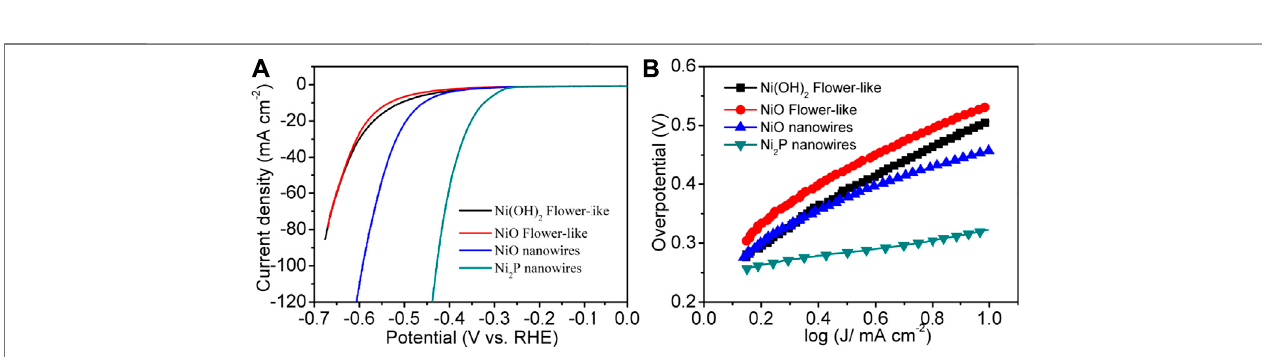
FIGURE 5 | (A) LSV curves of Ni 2 P nanowires, NiO nanowires, Ni(OH) 2 fl ower-like at 5 mV s − 1 in 1 M KOH from − 0.7 – 0 V vs. RHE. (B) Tafel plots of the HER activity.